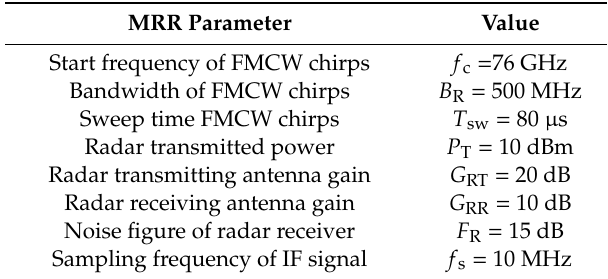
Table 1. Automotive medium-range radars (MRR)